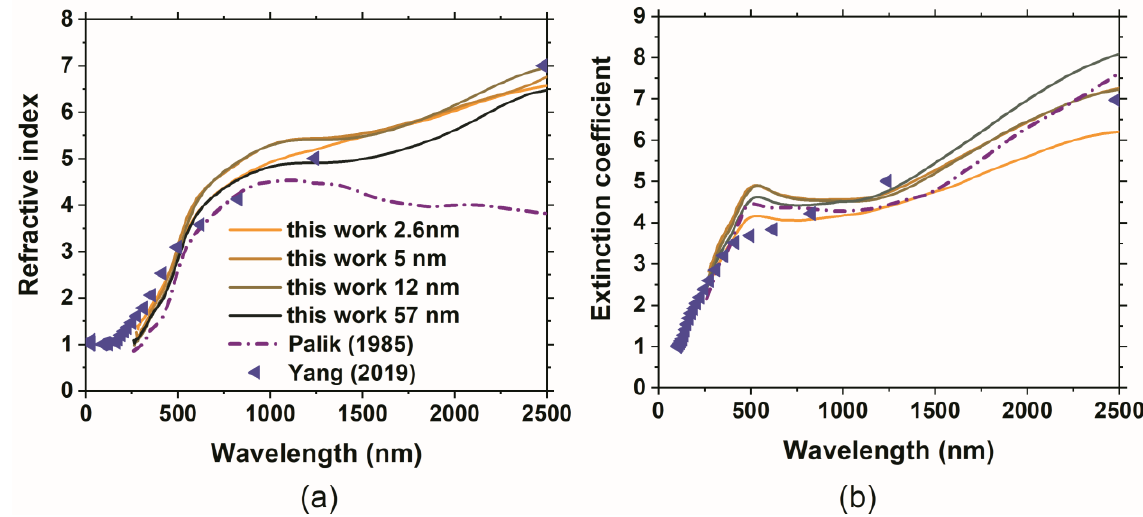
Figure 8. The optical constants of Cr films: ( a ) refractive index and ( b ) extinction coefficient.